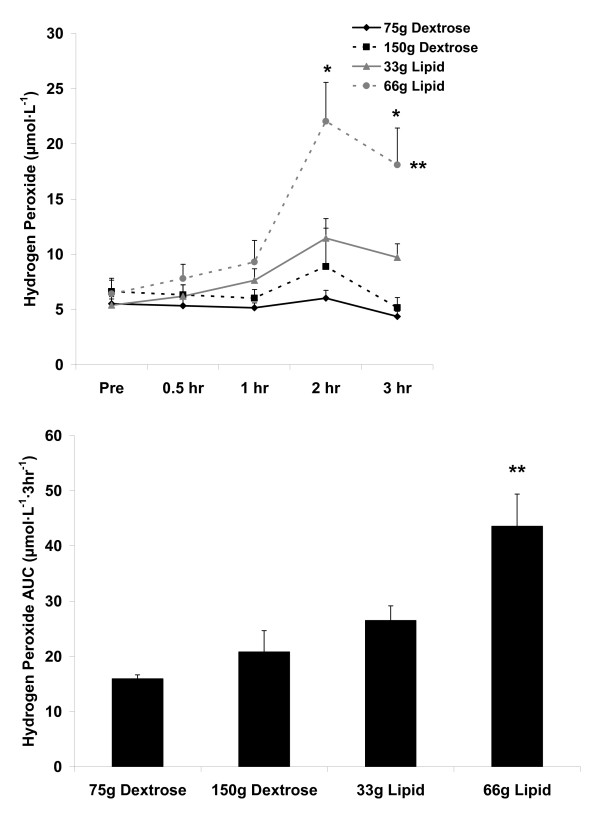
Blood hydrogen peroxide before and following the consumption of a dextrose or lipid meal in young healthy men. Data are mean ± SEM. **Meal effect (p < 0.0001); 66 g Lipid > 33 g Lipid, 75 g Dextrose, and 150 g Dextrose. *Time effect (p < 0.0001); 2 hr > Pre, 0.5 hr, and 1 hr; 3 hr > Pre. Meal × Time effect (p = 0.0002). **AUC effect (p = 0.0001); 66 g Lipid > 33 g Lipid, 75 g Dextrose, and 150 g Dextrose.